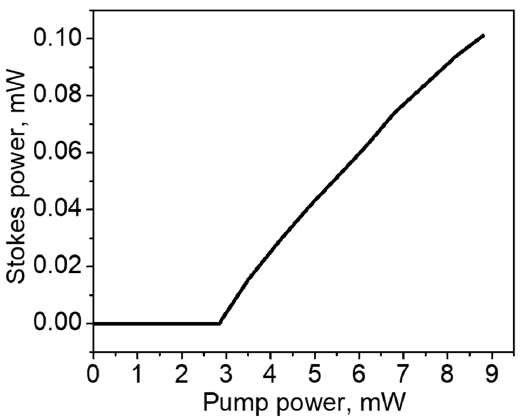
Figure A3. Stokes output power as a function of the pump output power.